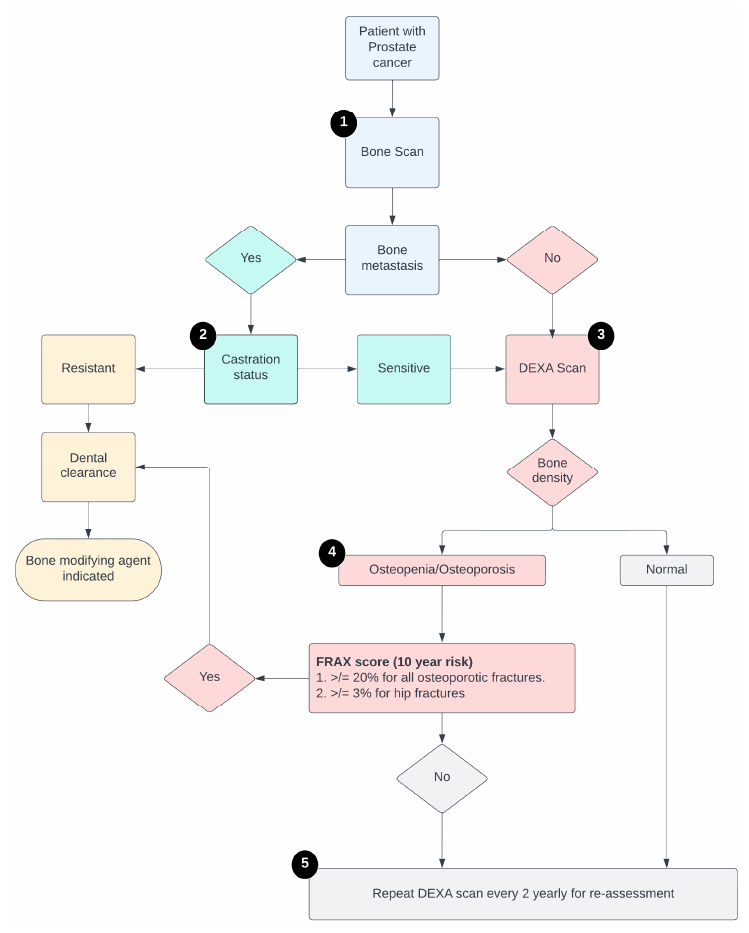
Figure 2. Schema of the steps of the algorithmic tool to follow before prescribing